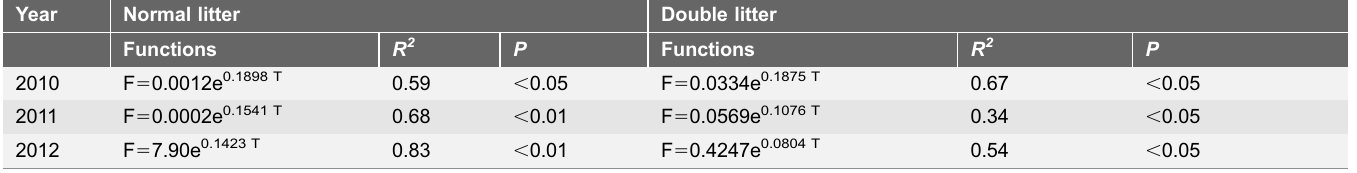
Values are from 2010 to 2012 at 95% confidence intervals; values were calculated using a procedure of REG of